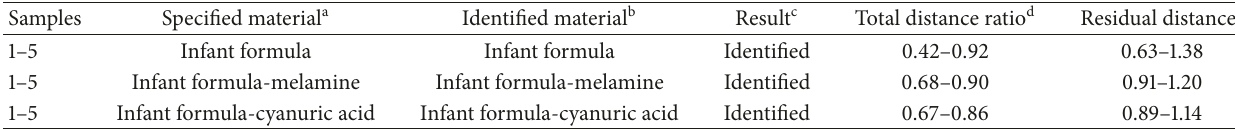
Table 5: External validation data of the SIMCA